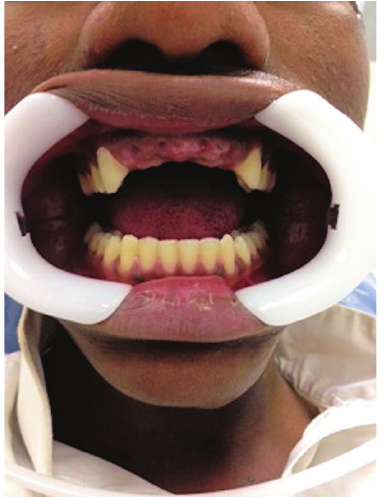
Figure 1: Photograph showing the missing